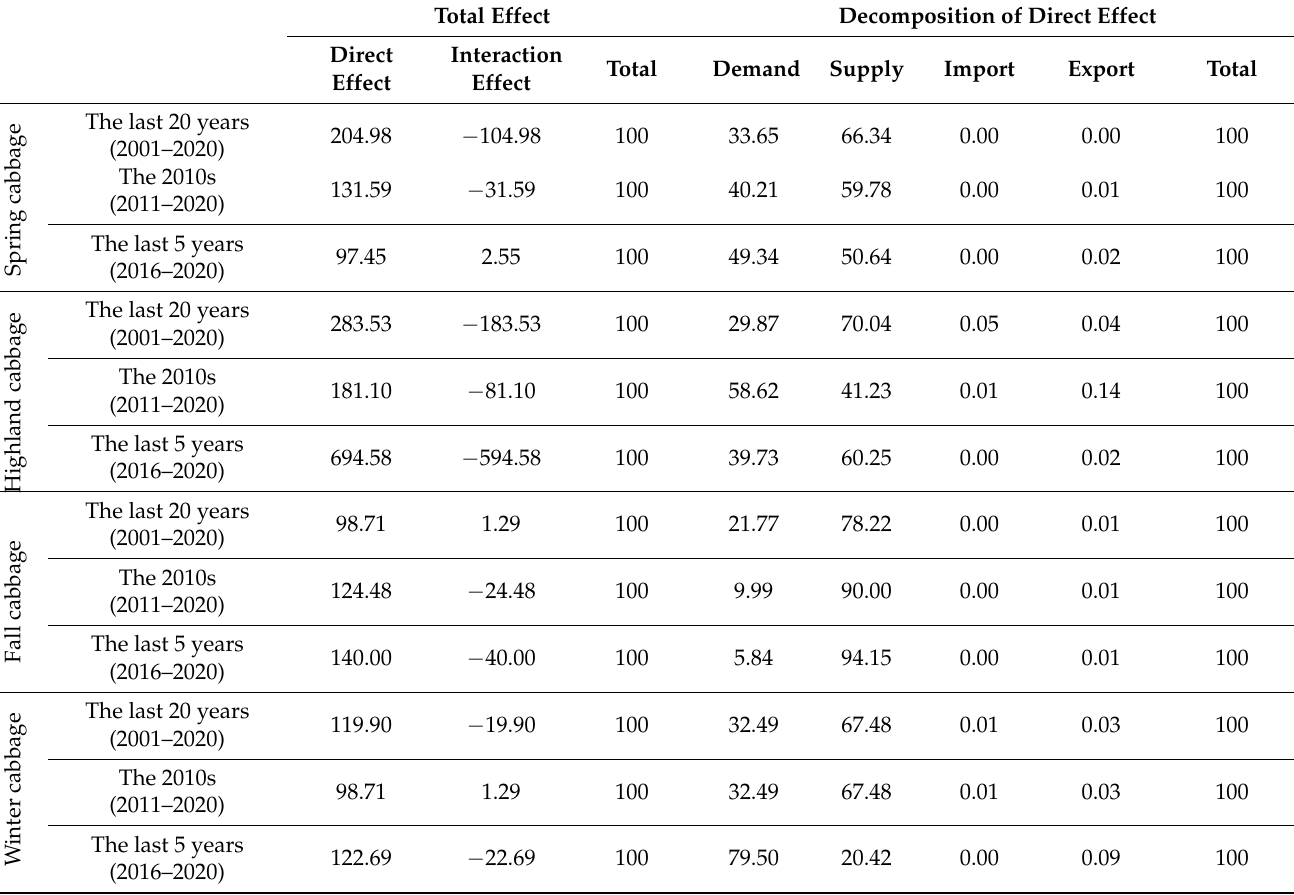
Table 4. Price fluctuation analysis results of